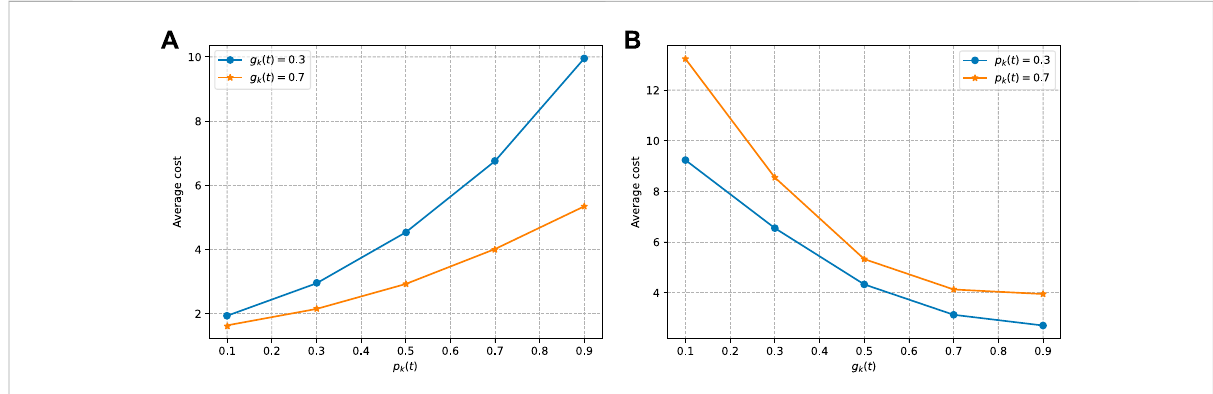
FIGURE 7 Averagecostunderdifferentuserrequestfrequenciesandenergyharvestingfrequency: (A) showstheaveragecostcausedbythesameenergy harvestingfrequencyanddifferentuserrequestfrequenciesand (B) showstheaveragecostcausedbythesameuserrequestfrequencyanddifferent energy harvesting